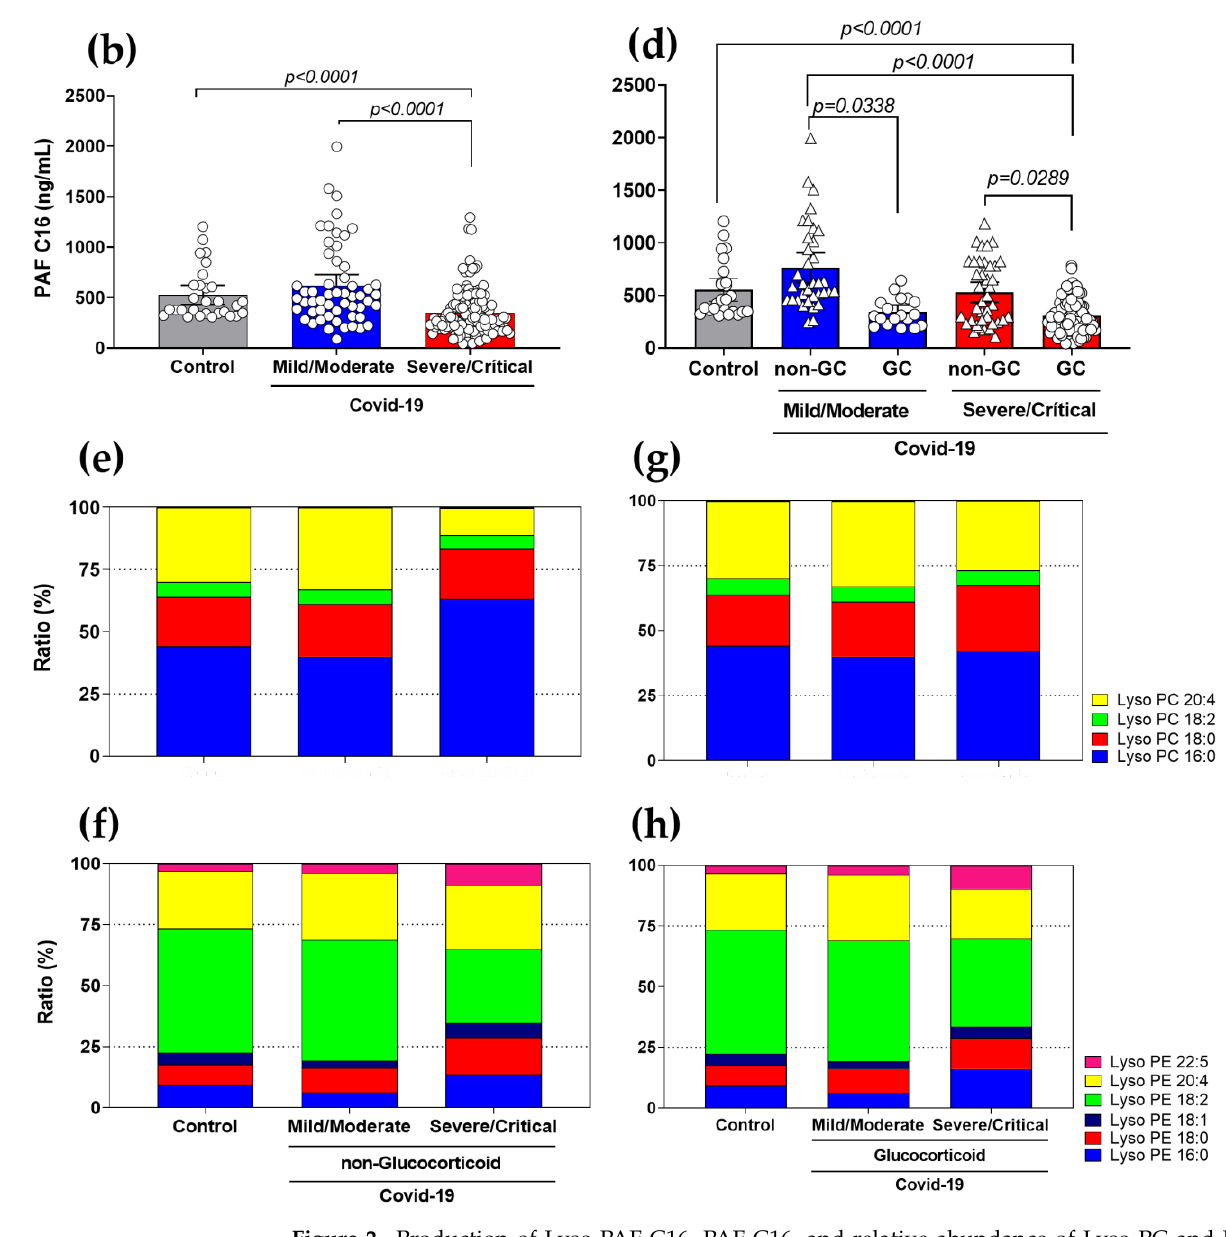
Figure 2. Production of Lyso-PAF C16, PAF C16, and relative abundance of Lyso-PC and Lyso-PE species in COVID-19 patients with the use of GCs. Levels of Lyso-PAF (16:0) ( a ) and PAF (16:0) ( b ) in COVID-19 patients (mild/moderate ( n = 55) and severe/critical ( n = 145) compared to healthy controls ( n = 35). COVID-19 patients who use/do not use GCs were segregated into mild/moderate (non-GC, n = 35 vs. GC, n = 20) and severe/critical (non-GC, n = 42 vs. GC, n = 103) show significant differences in Lyso-PAF (16:0) ( c ) and PAF (16:0) ( d ) compared to healthy controls. Relative abundance (ratio %) production of Lyso-PCs ( e ) and Lyso-PEs ( f ) in individuals not treated with GCs (mild/moderate, n = 35 and severe/critical, n = 42); Lyso-PCs ( g ) and Lyso-PEs ( h ) of GC-treated individuals (mild/moderate, n = 20 and severe/critical, n = 103). Statistical analyses were performed using the Kruskal–Wallis multiple comparison test (non-parametric), followed by Dunn’s post-test. Data are expressed as median in boxplot graphs with minimum and maximum values with a confidence interval of +/ − 95%. Significance levels shown are based on statistically significant p -values between groups, significant for p < 0.05. Area ratio: area ratio between the metabolite and the correspondence internal